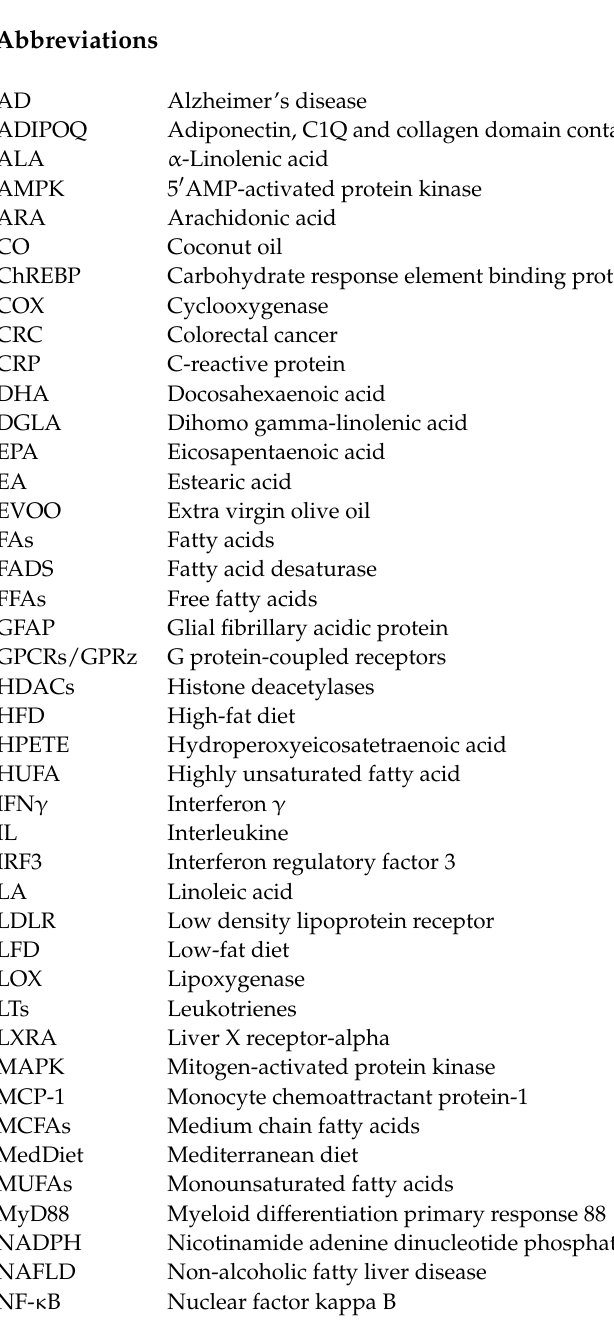
composition in animals, Table S2: The impact of TFA (trans fatty acids) on gut microbiota compo- sition in animals, Table S3: The impact of MUFA (monounsaturated fatty acids) on gut microbiota composition in animals, Table S4: The impact of PUFA-n-3 (polyunsaturated fatty acids-omega3) on gut microbiota composition in animals, Table S5: The impact of PUFA-n-6 (polyunsaturated fatty acids-omega6) on gut microbiota composition in